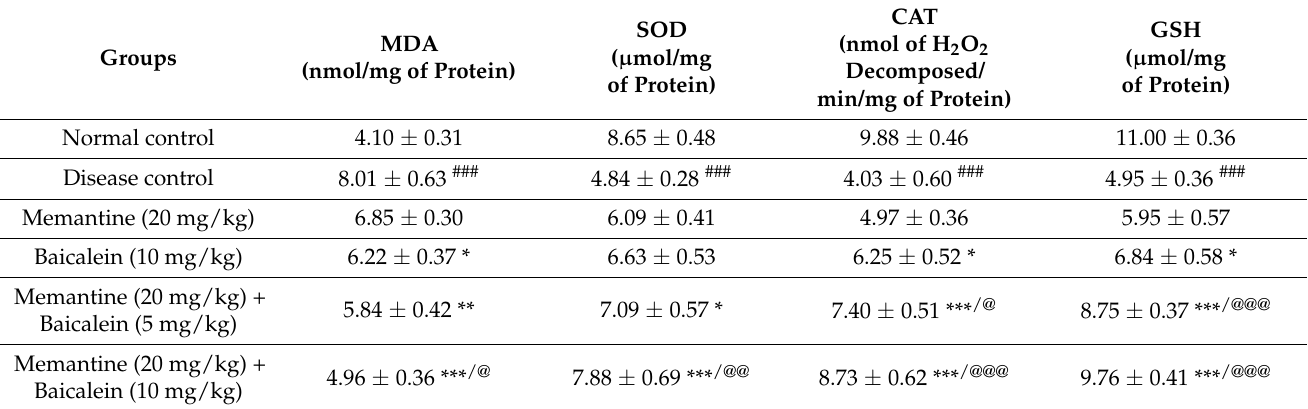
Table 1. Effect of A β (1–42) , baicalein and baicalein with memantine on oxidative stress parameters in the rat brain hippocampus.